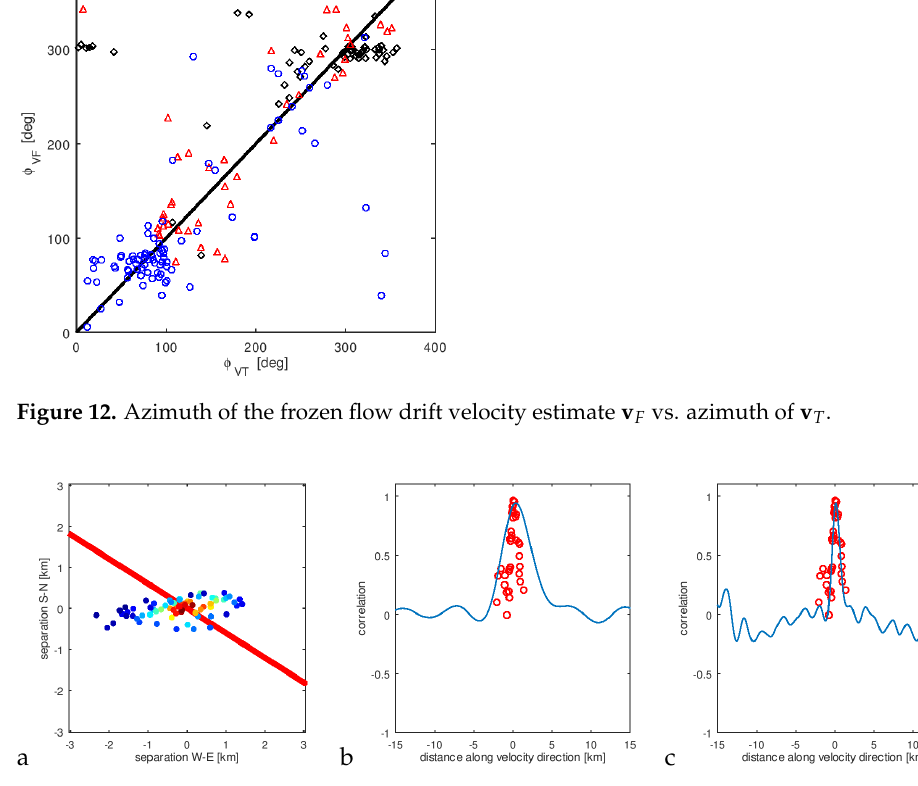
Figure 13. An example of the procedure for obtaining the experimental velocity scaling factor: ( a )—a bar containing spatial correlations taken for comparison, ( b )—spatial correlations superimposed on temporal cross-correlation between a pair of stations (they do not overlap), ( c )—spatial correlations superimposed on temporal cross-correlation between a pair of stations after the optimal speed scaling—minimising the expression